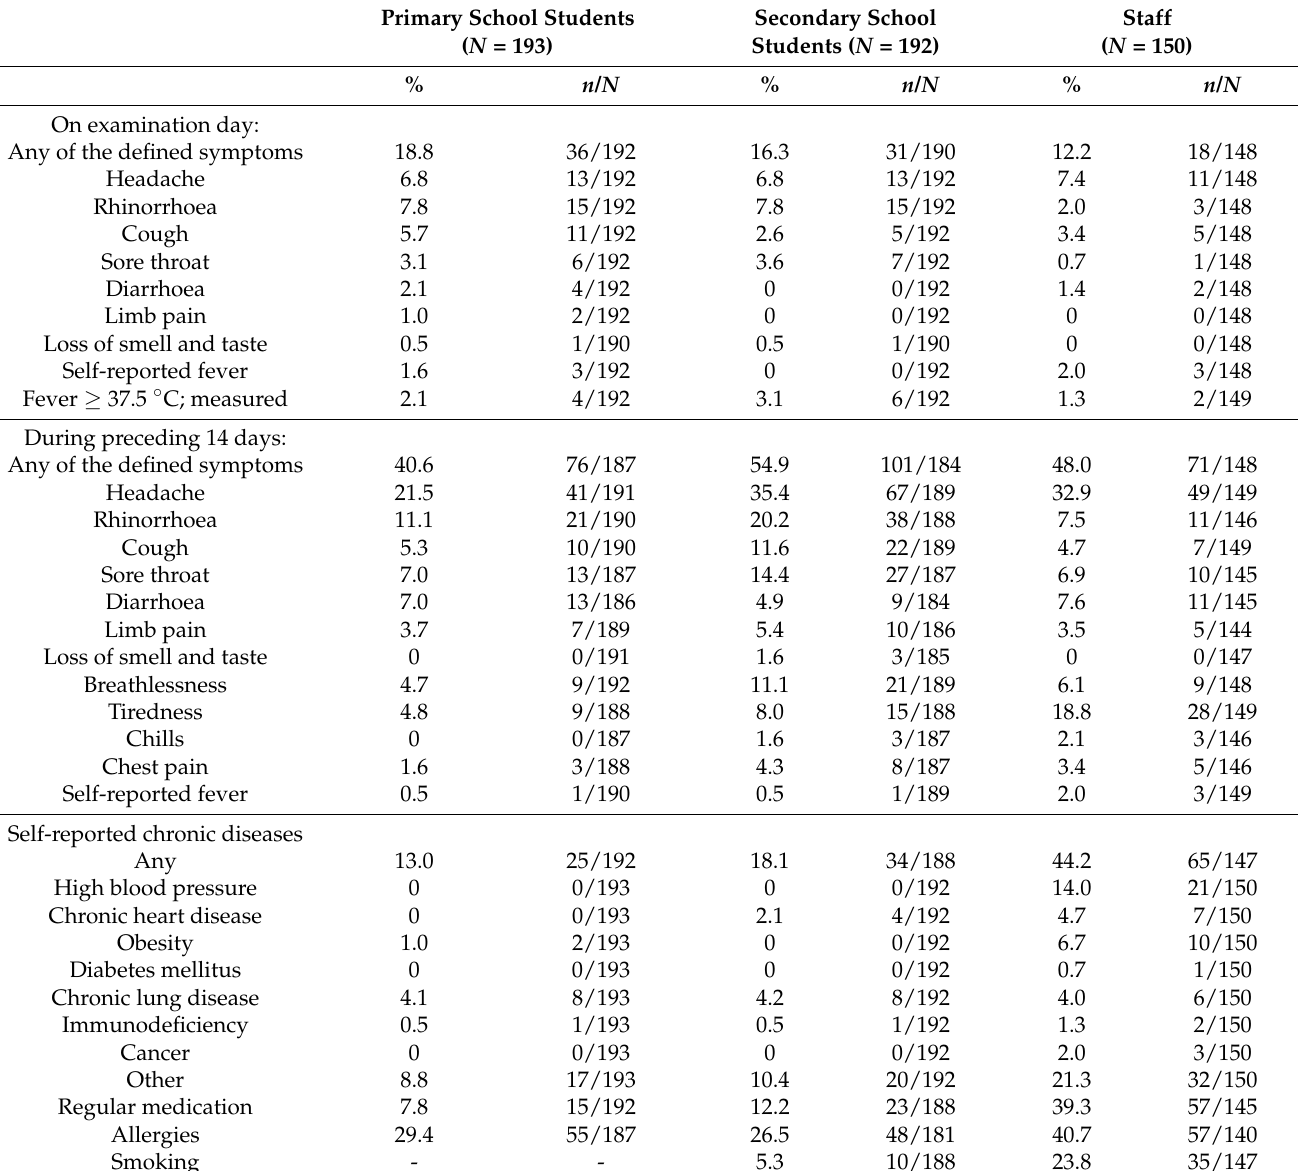
Table 1. Reported symptoms on examination day, during the preceding 14 days, and medical